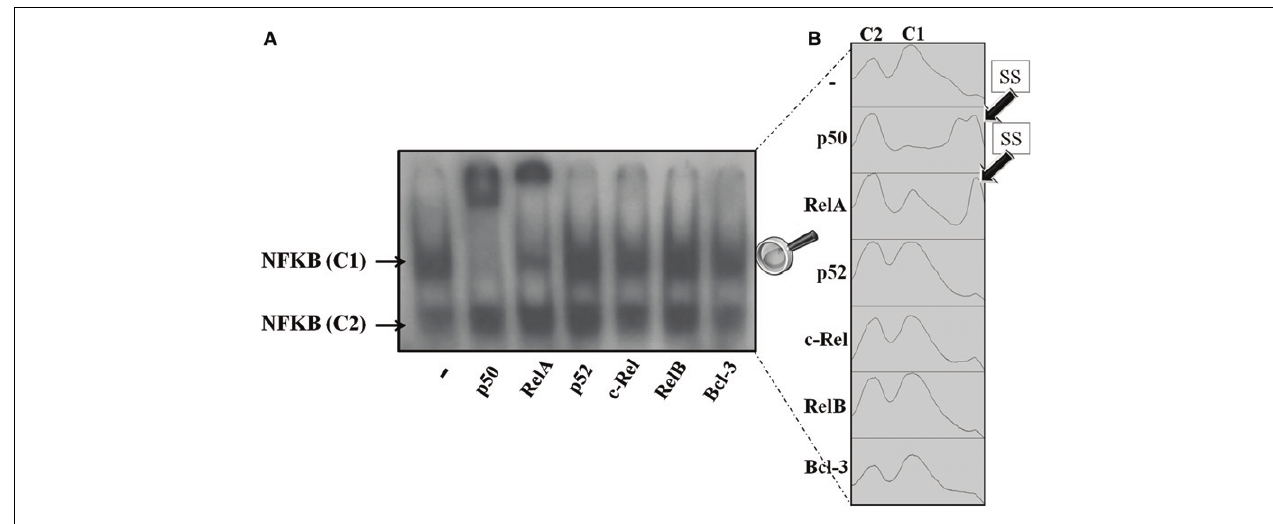
shifted bands corresponding to each column in the representative gel. The first and second peaks correspond to complexes C2 and C1, respectively. Anti-RelA and anti-p50 supershifted the C1 complex in a partial and a total manner, respectively. Each point was obtained from a pool of 3–4